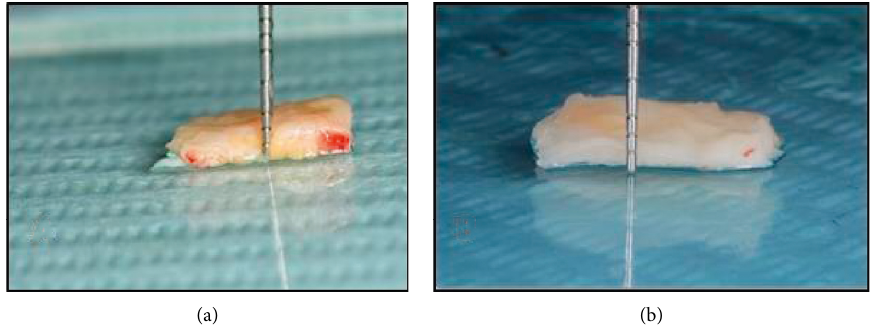
Figure 1: Clinical photo shows (a) harvested epithelialized free gingival graft. (b) Deepithelialized free gingival graft.